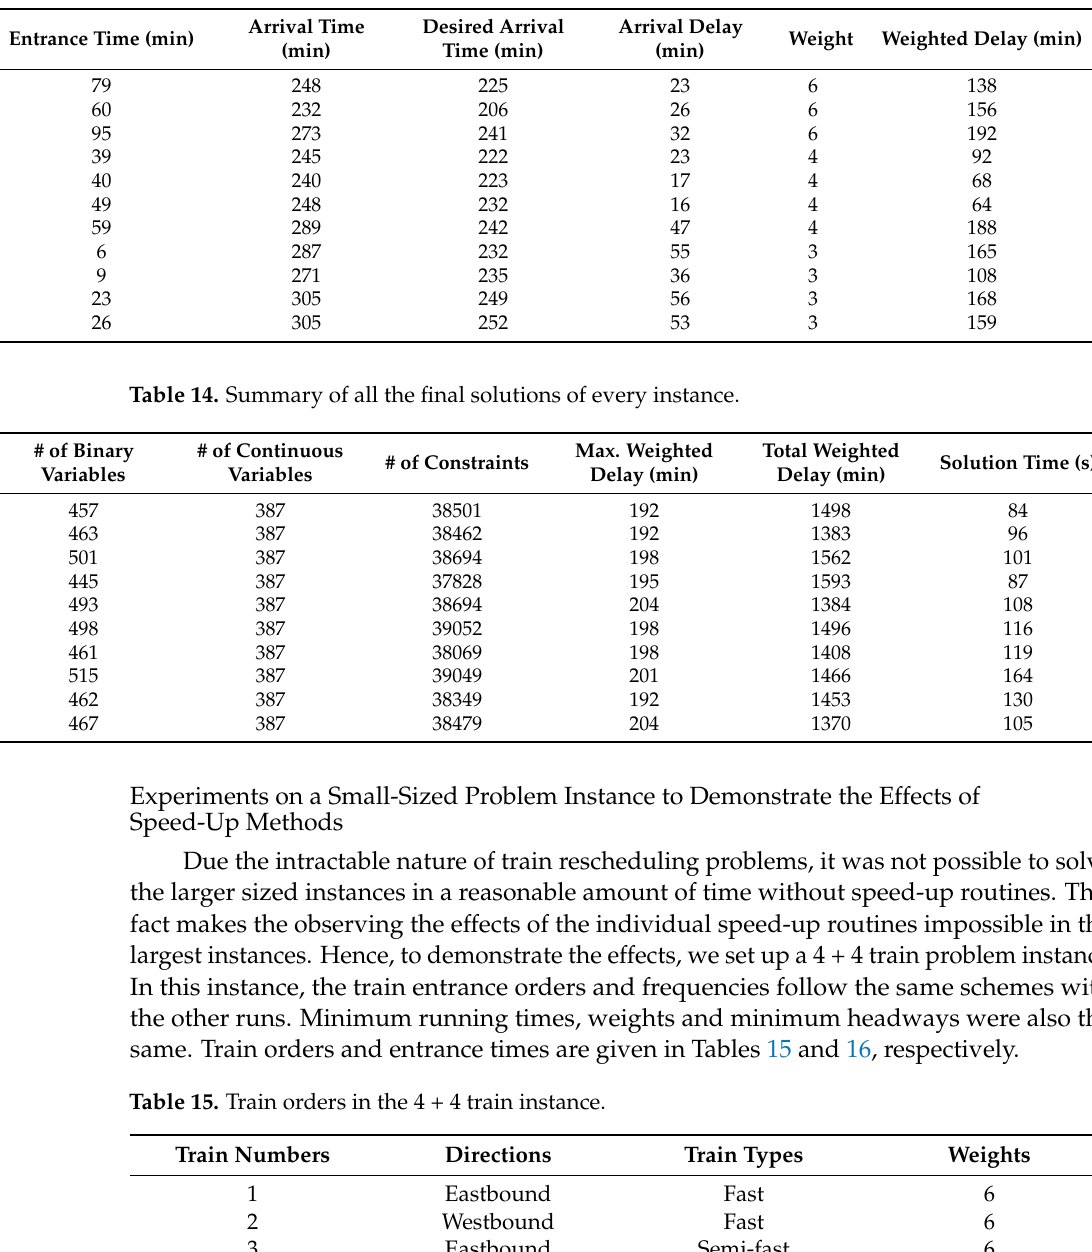
Table 13. Summary of the solution of Instance 1.